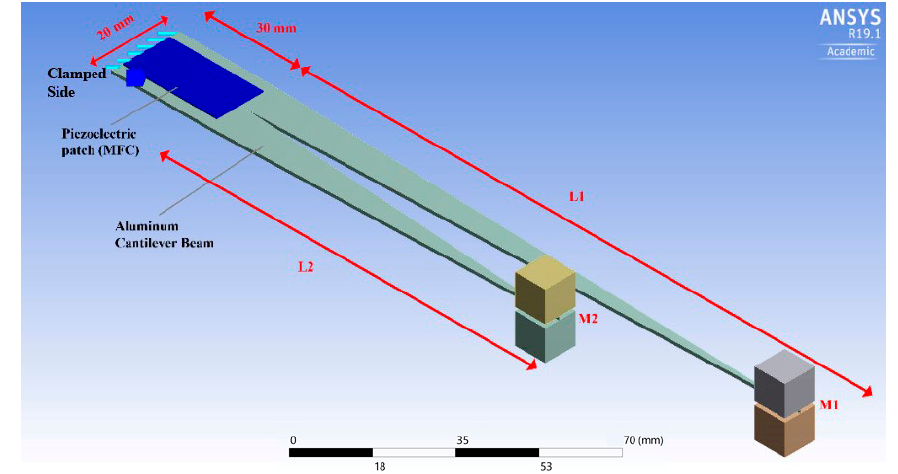
Figure 1. Schematic of the proposed multiresonant piezoelectric energy harvester (MRPEH) design.